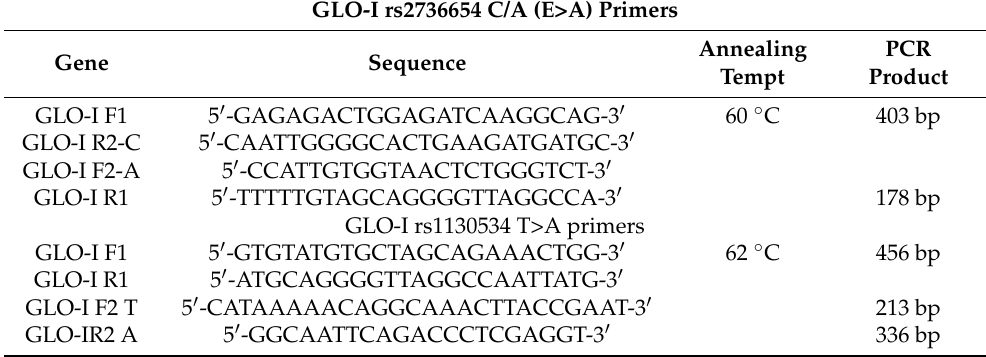
Table 1. Allele-Specific PCR (AS-PCR) primers for GLO1 SNPs.